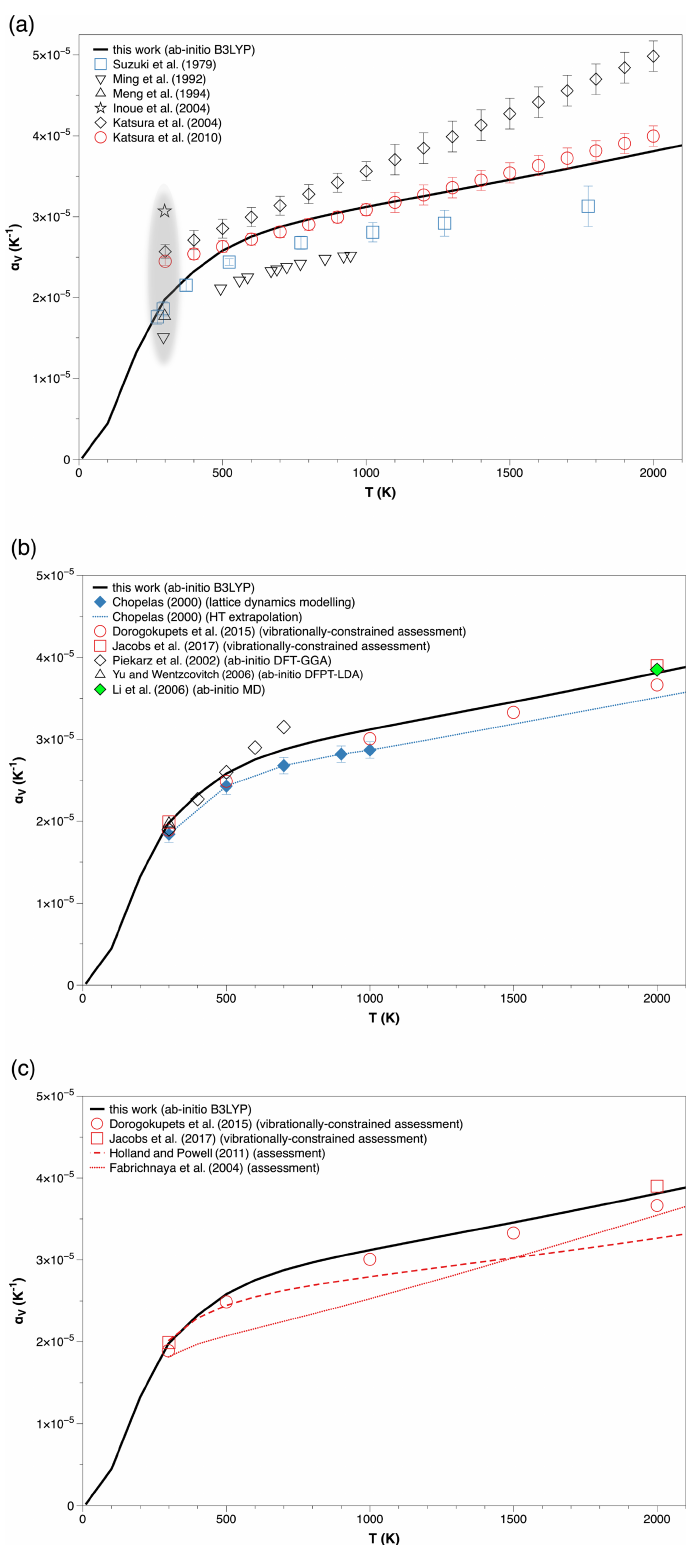
Figure 4. Ab initio B3LYP volume thermal expansivity ( α V ) of Mg 2 SiO 4 ringwoodite at zero pressure, compared with (a) experimental data (grey shaded area highlights scattering of values at ambient conditions), (b) different theoretical simulations and (c) thermodynamic